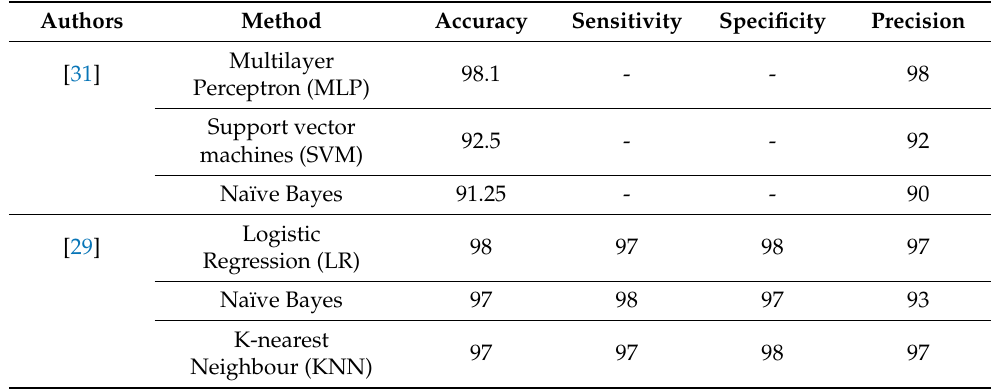
Table 8. Performance comparison and the results gained from other